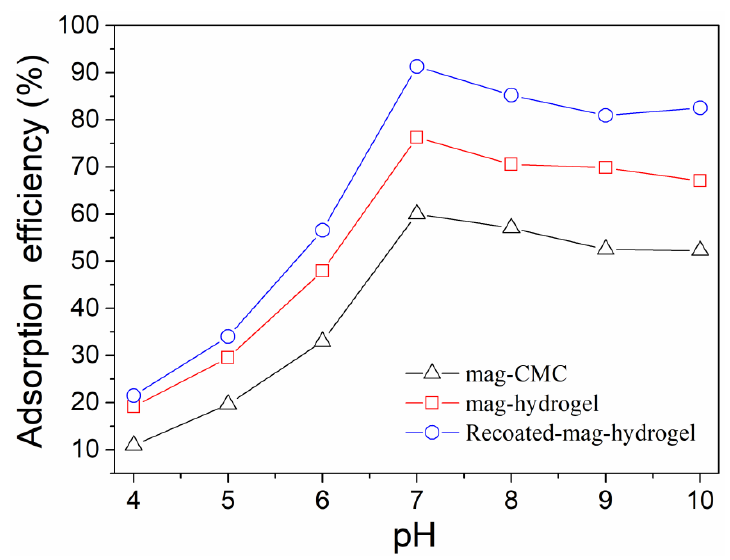
Figure 8. Effect of solution pH on MB adsorption onto magnetic nanocomposites.